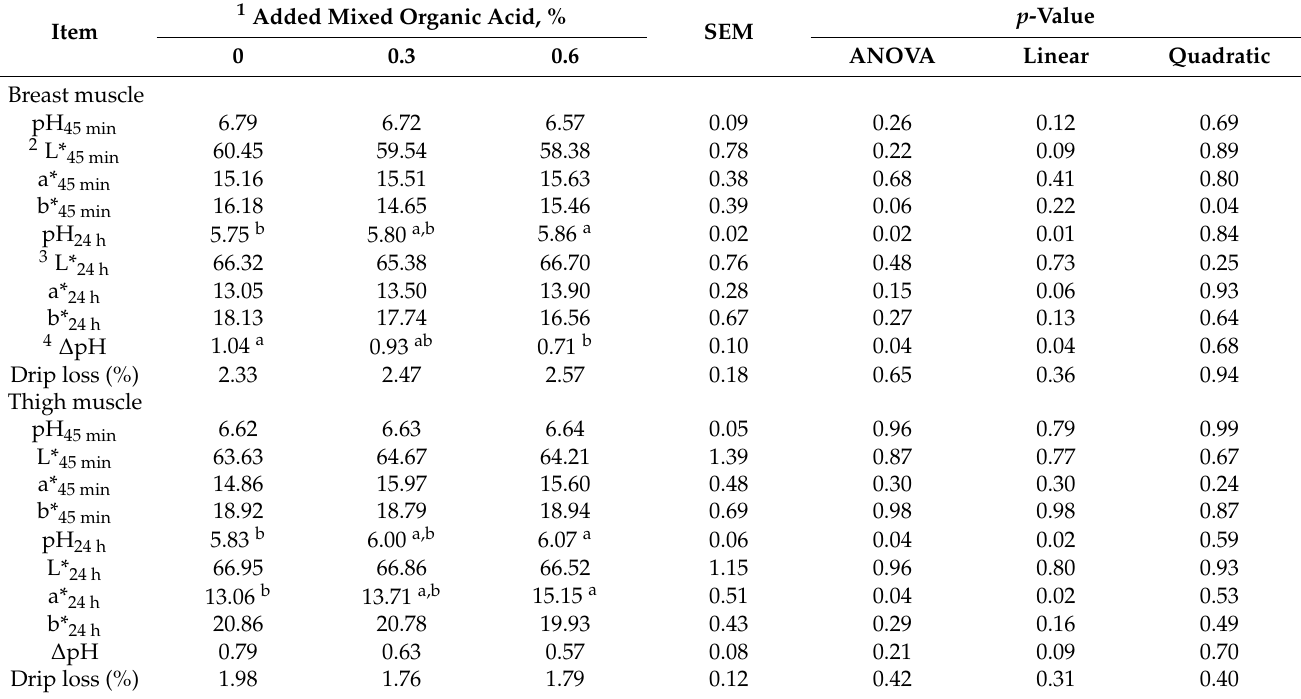
Table 3. Breast and thigh muscle quality of 42 d broiler chickens as affected by dietary MOA